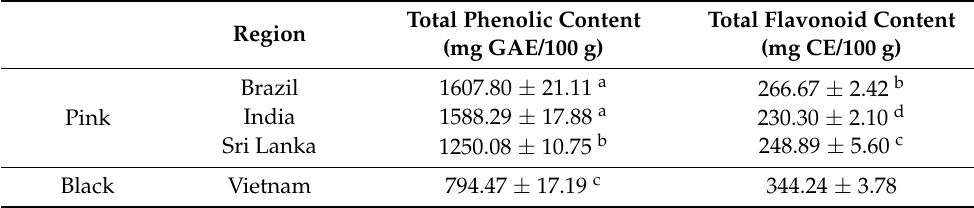
Table 2. Total flavonoid and total phenolic contents of pink and black peppers.